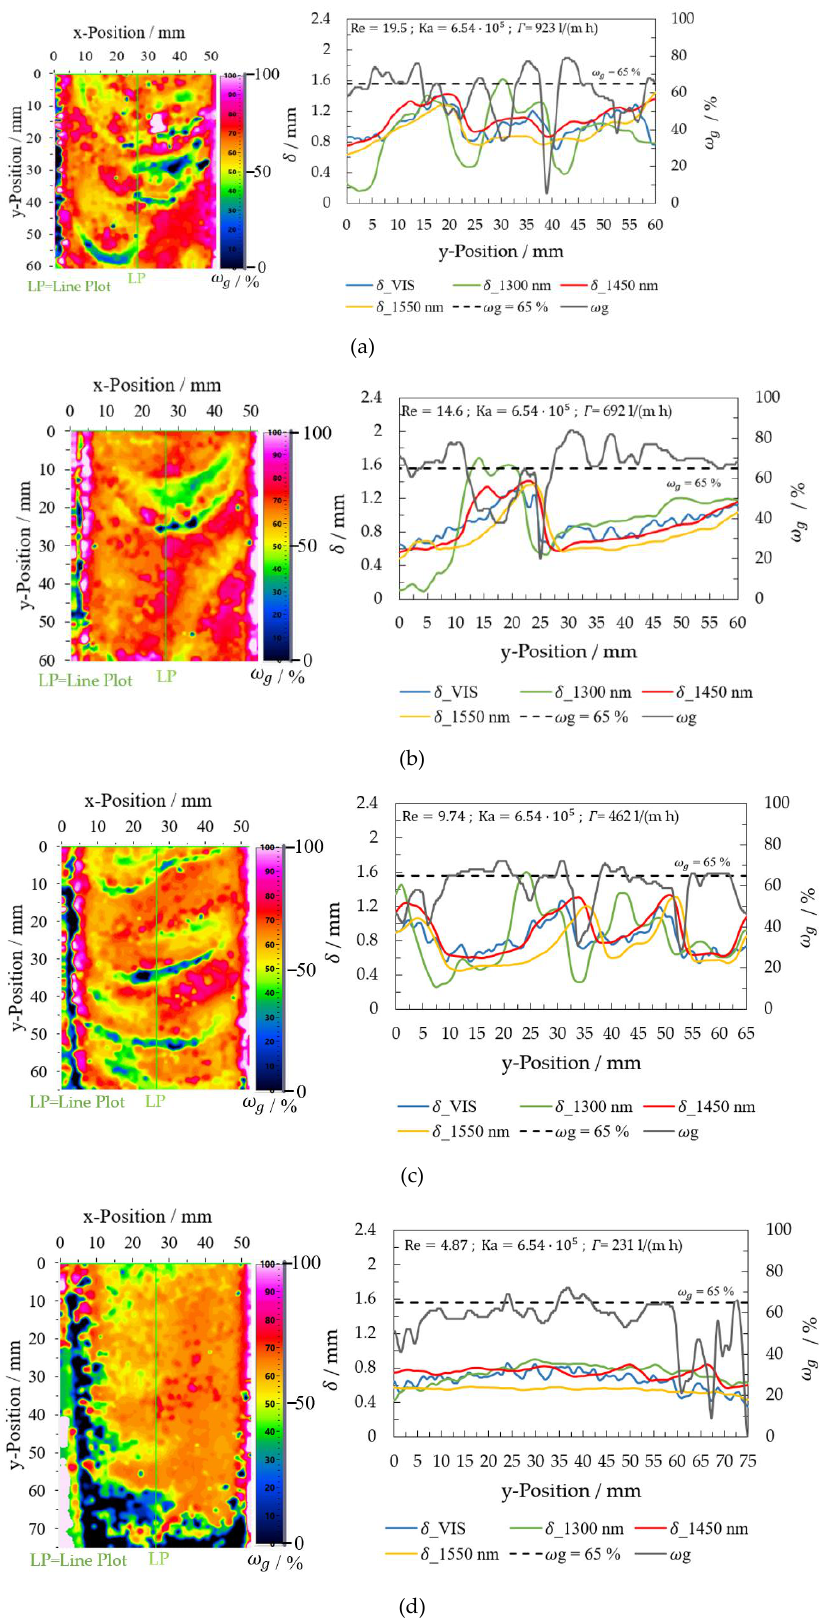
Figure 17. Glycerol concentration fields in falling films at ω g = 0.65 g glyc g total − 1 calculated using multiwavelength image analysis ( a ) Re = 19.5 ( b ) Re = 14.6 ( c ) Re = 9.74 ( d ) Re = 4.87.